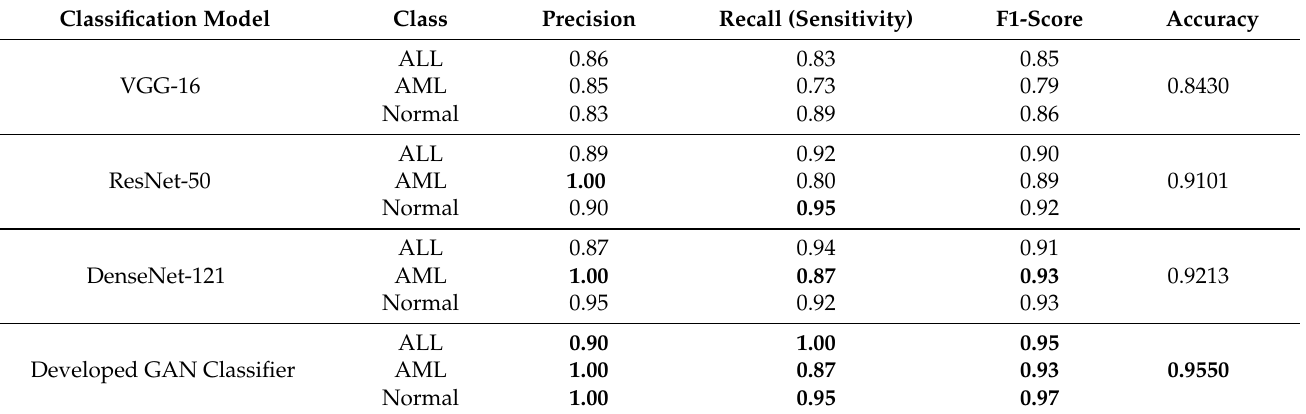
Table 3. Evaluation metrics for all tested multi-class classifiers on microscopic blood